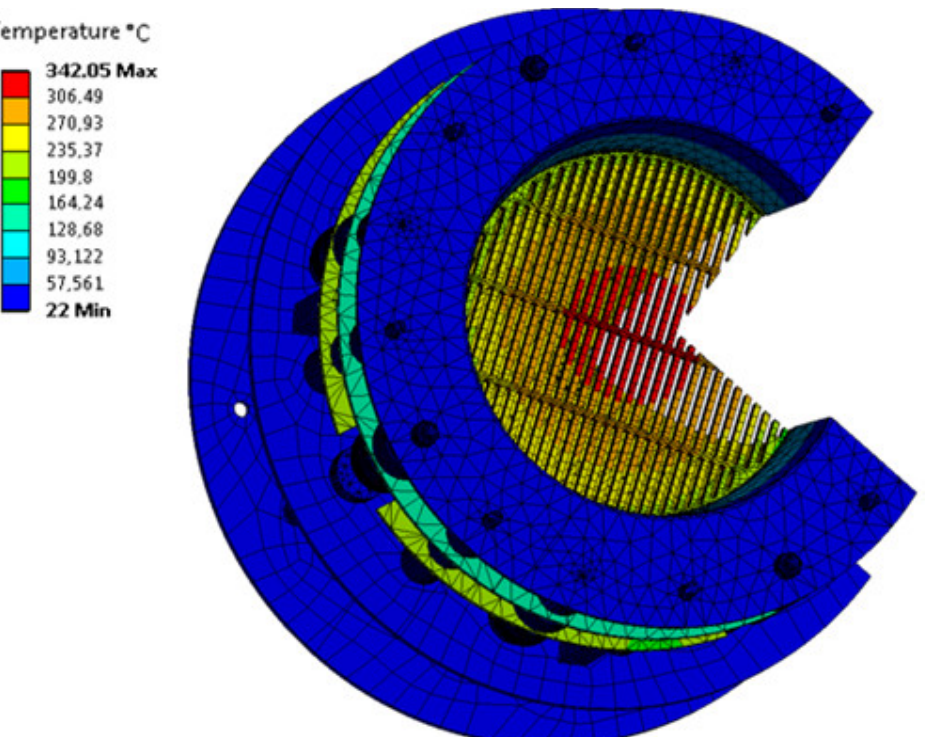
Figure 3. Predicted temperature patterns in the IS from the Slit-Type IES end.